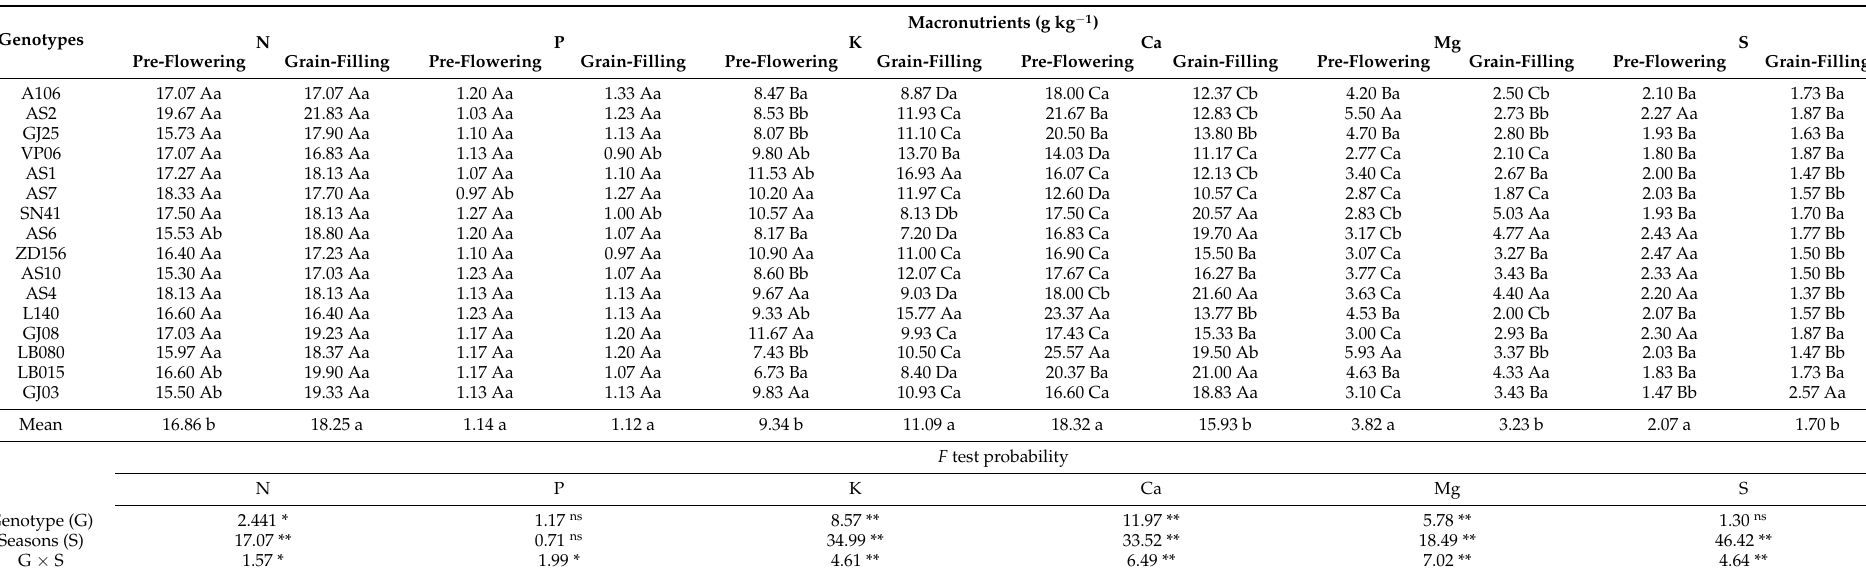
Table 7. Leaf macronutrient concentrations in 16 Coffea canephora genotypes during pre-flowering and grain-filling. Alta Floresta D’Oeste, Rond ô nia,